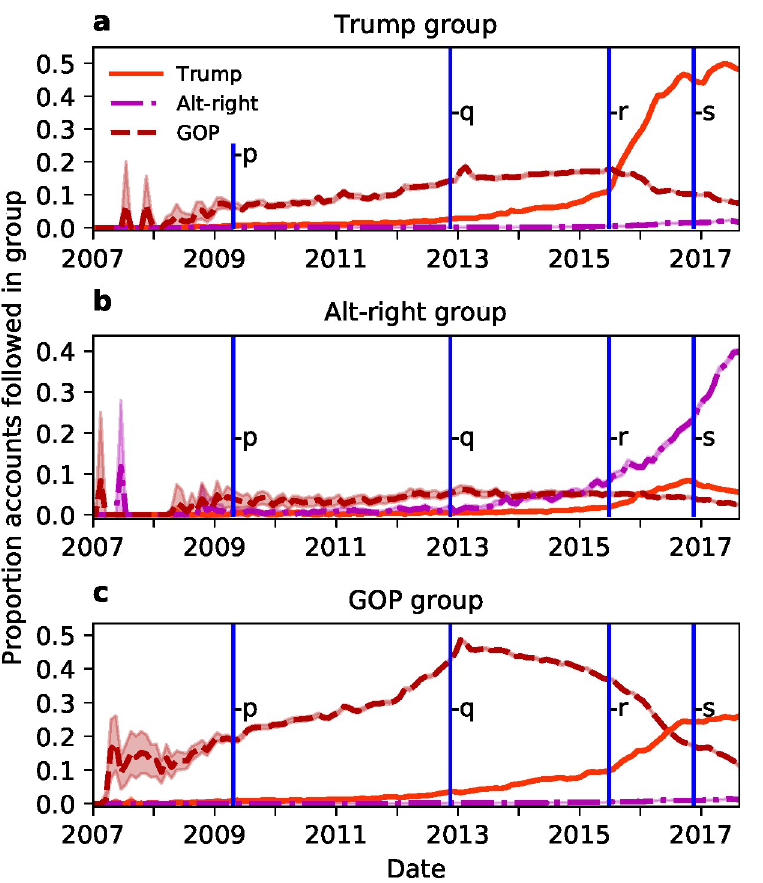
Fig 3. Accounts followed shifted from GOP to the Trump group. After the 2012 election, there was a shift from following accounts in the GOP group to following accounts in the Trump group (panels a , b and c ). Members of the Alt-right group have increasingly followed one another over time (panel b ), but are not followed by GOP or Trump group members (panels a and b ). Each of the three panels show how the members of one focal group followed members of the groups over time. The time traces show the proportions of accounts that were followed in the Trump (orange line), Alt-right (purple dash-dotted line), or GOP (red dashed line) groups, averaged over each member in the originating group. Events shown ( p , q , r , and s ) are as in Fig 2. The data points have very small 95% confidence intervals (shaded areas, see Methods) which demonstrates that this pattern is highly statistically significant: The members of a group largely changed their following-behaviour in